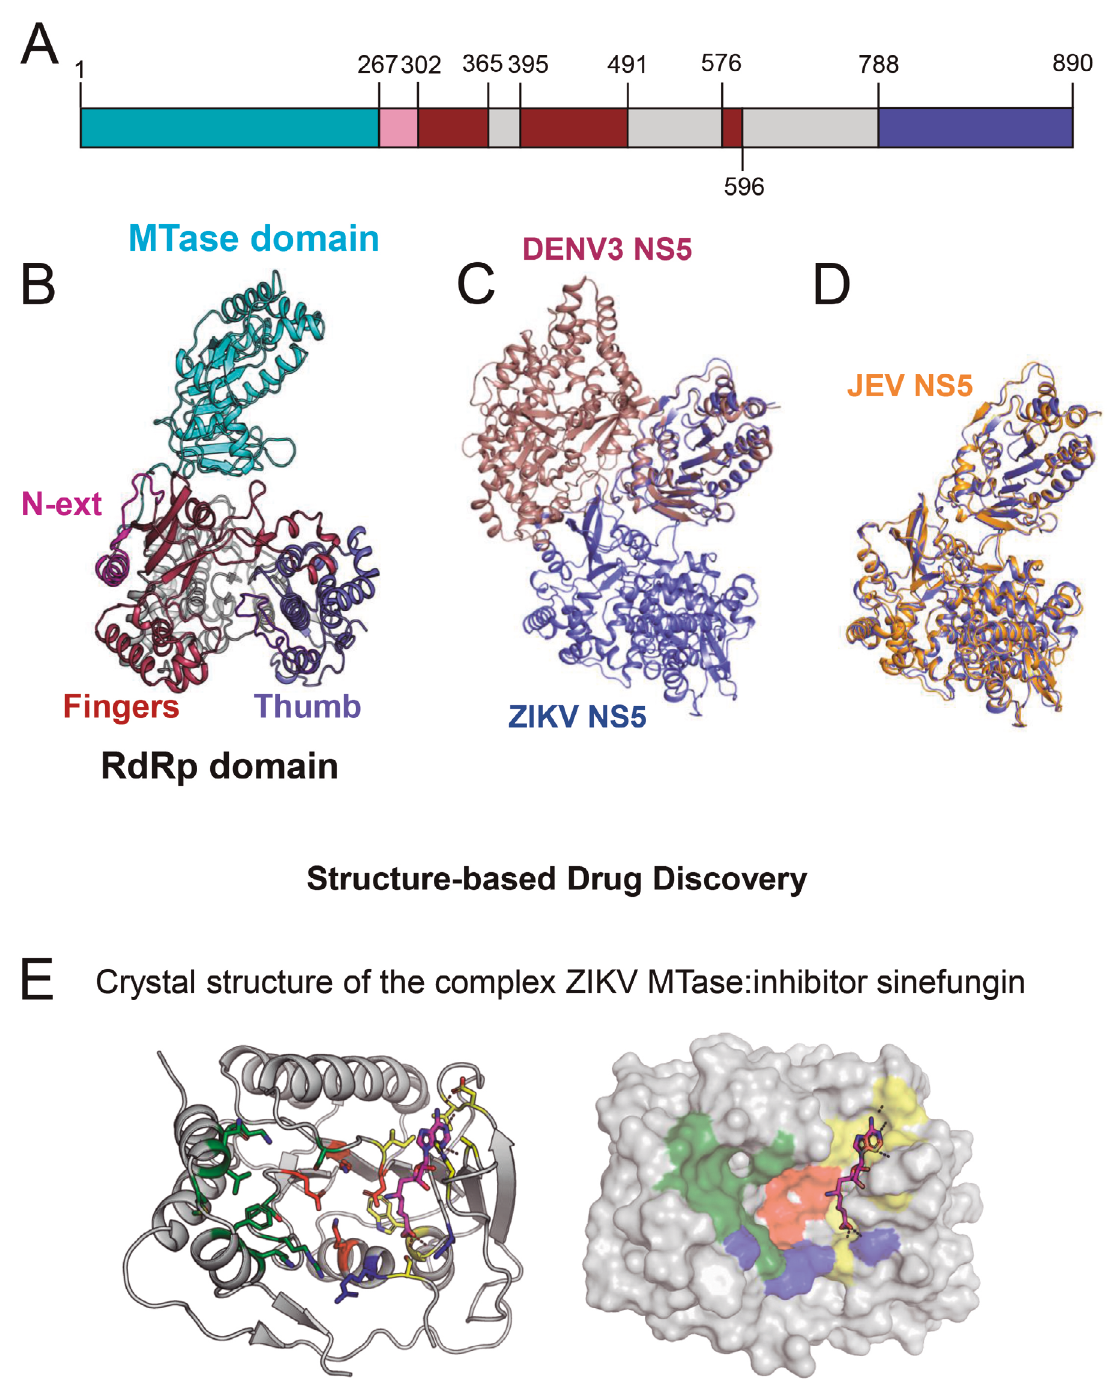
Figure 4. (A) Schematic domain organization of ZIKV NS5. (B) Structure of ZIKV NS5 (PDB ID: 5FTR). (C) Superposition of NS5 structures of DENV3 (PDB ID: 5CCV) and ZIKV (PDB ID: 5FTR). (D) Superposition of NS5 structures of JEV (PDB ID: 4K6M) and ZIKV (PDB ID: 5FTR). (E) Structure of NS5 Mtase complexed with SAM-analogue inhibitor sinefungin (PDB ID: